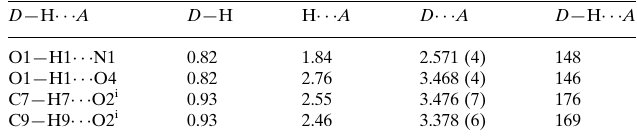
Hydrogen-bond geometry (A˚ , (cid:2)